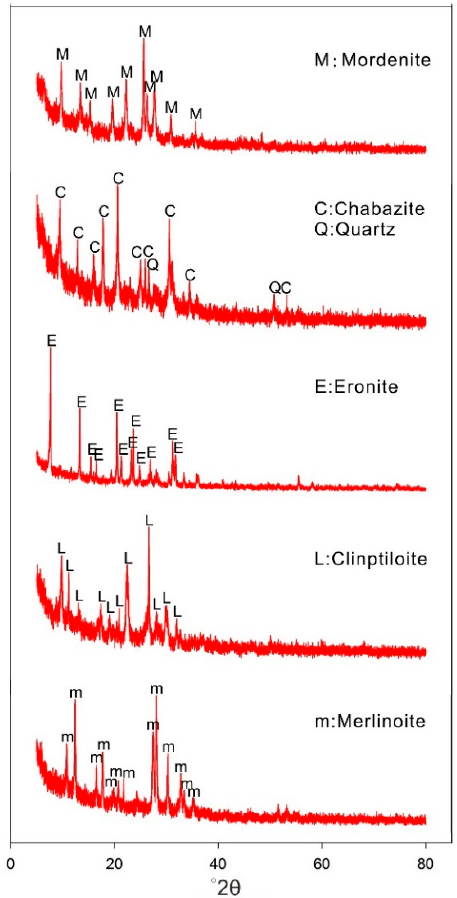
Figure 1. X-ray Diffraction (XRD) results of each zeolite sample.